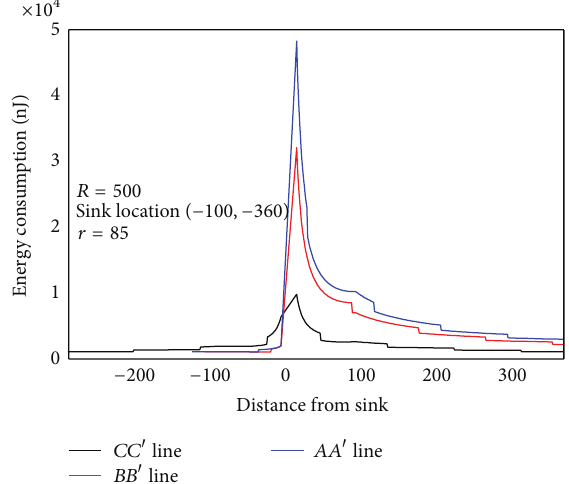
Figure 8: Energy consumption of nodes different distances from the sink in different directions.